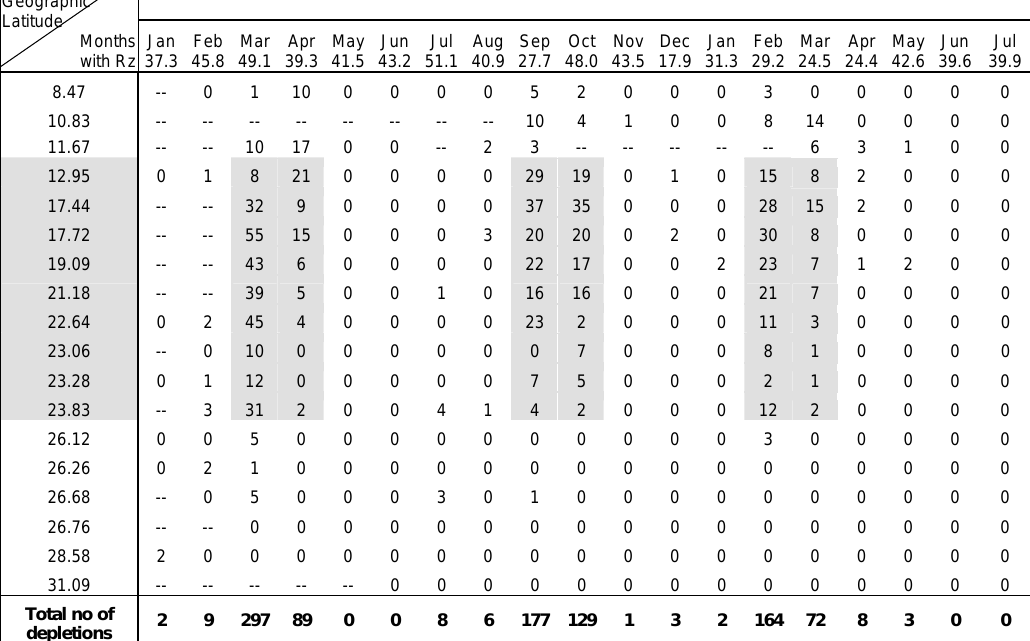
Table 1. Number of depletions observed from each station (latitudes of each station tabulated) for every month during the period from January 2004 to February 2005. The monthly mean sunspot numbers are also shown under each of the months. Table 1 Number of depletions observed for the months during Jan 2004 to Jul 2005 Station Geographic Latitude Months